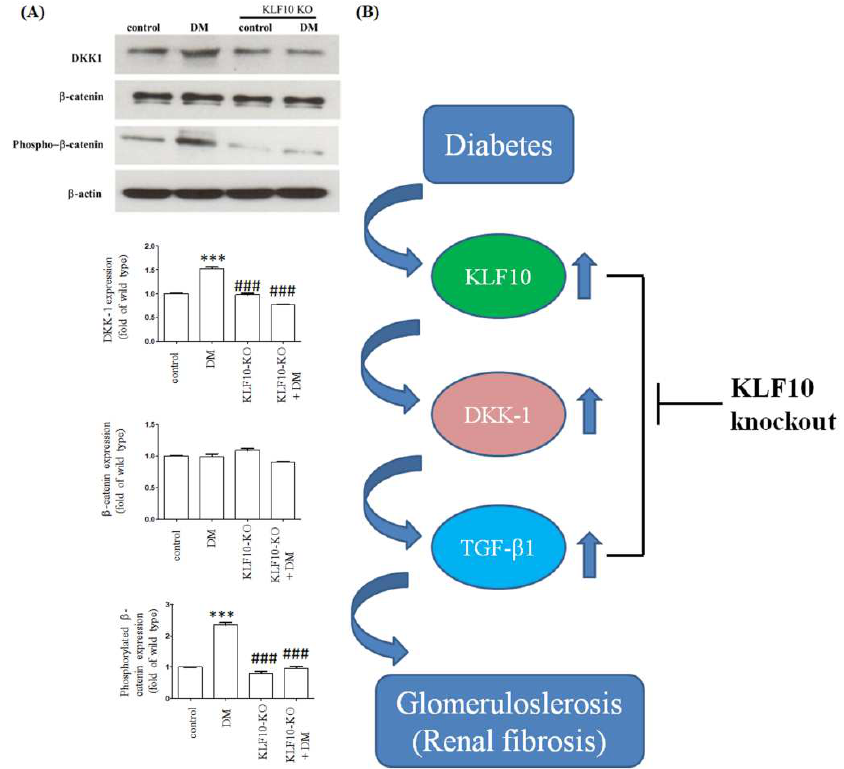
Figure 6. Knockout of KLF10 mitigated diabetes-induced DKK-1 and phosphorylated β-catenin expression. ( A ) Western blot analysis was conducted using proteins extracted from the kidney of control or KLF10 knockout mice with or without diabetes (DM). Data are presented as means ± standard deviation obtained from three different mice. ***: p < 0.001 compared with the control group. ###: p < 0.001 compared with the DM group. ( B ) KLF10 participated in renal fibrogenesis through the regulation of DKK-1 and its downstream pathway.